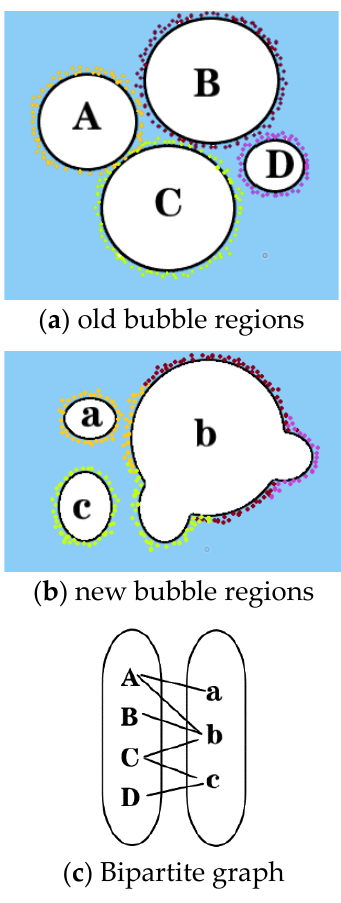
Figure 4. Bubble ID mapping legend.